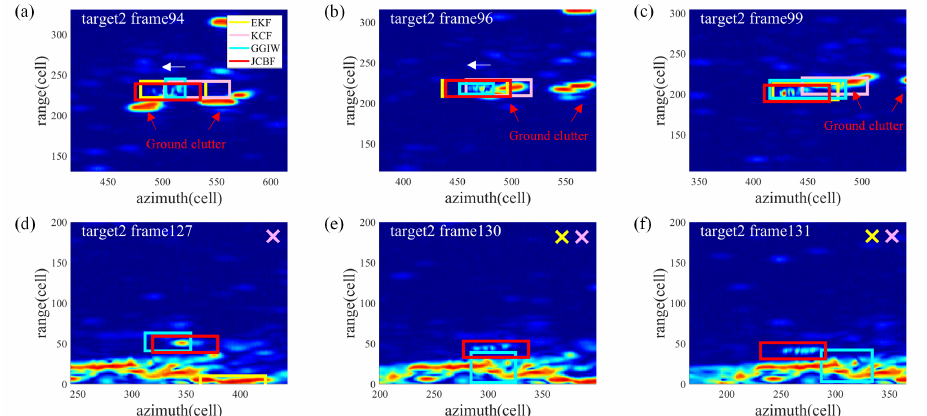
Figure 9. Tracking results of target 2 at some key frames. ( a – f ) Tracking results for each filter when target 2 is obscured by clutter.